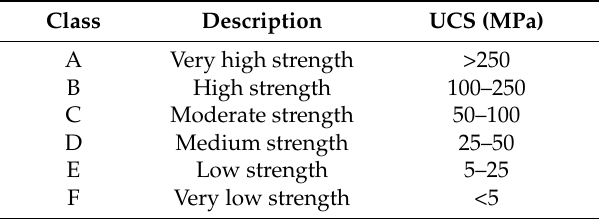
Table 2. Strength classification of intact and jointed rocks (Ramamurthy & Arora,